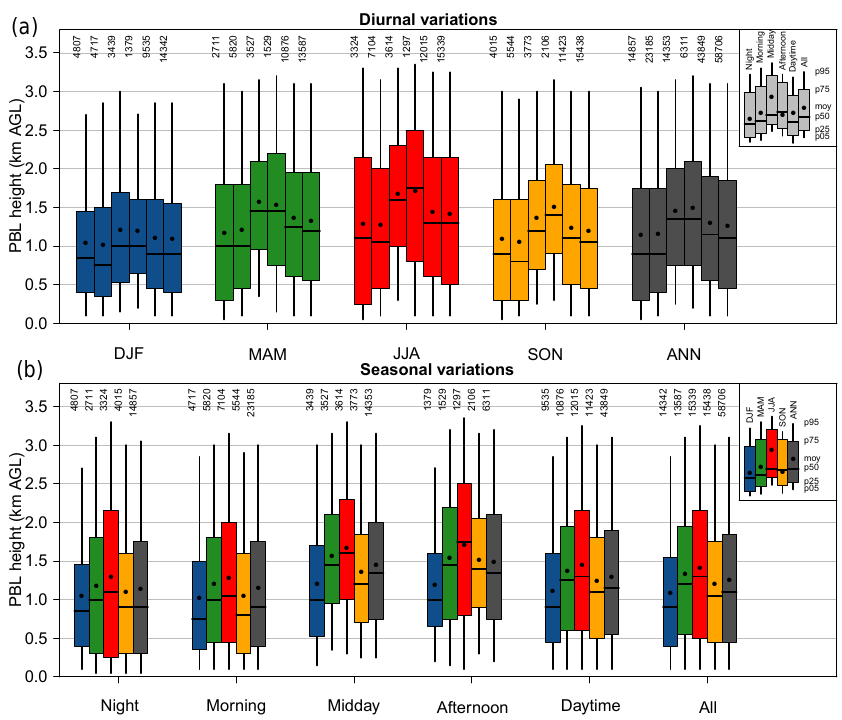
Figure 5. Diurnal ( a ) and seasonal ( b ) variations in the averaged PBL heights. For all combinations of season and time of day, the number of available profiles is indicated above the box